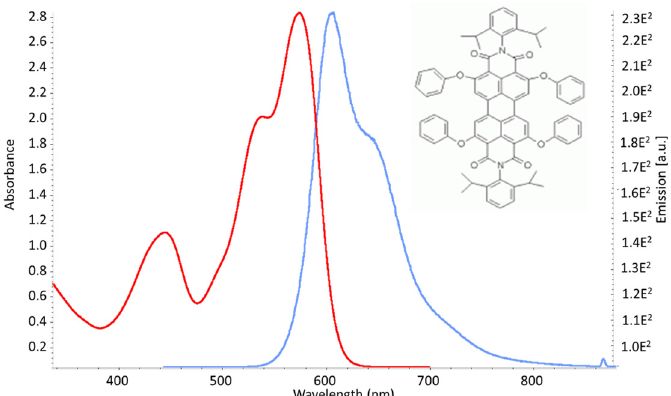
Figure 3. Absorption (red curve) and photoluminescent emission (blue curve) spectra of Lumogen F305.